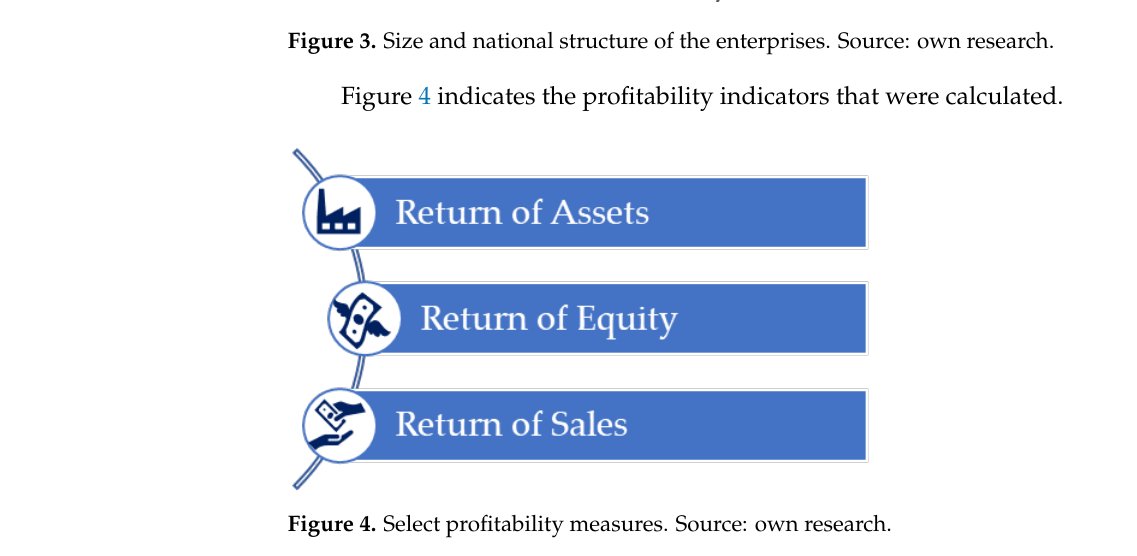
Figure 3. Size and national structure of the enterprises. Source: own research .